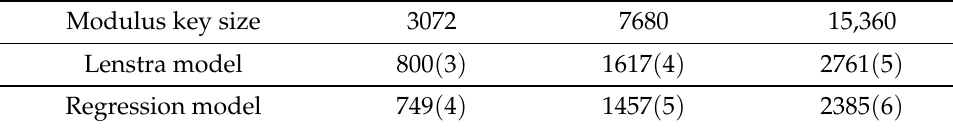
Table 2. Equivalent key